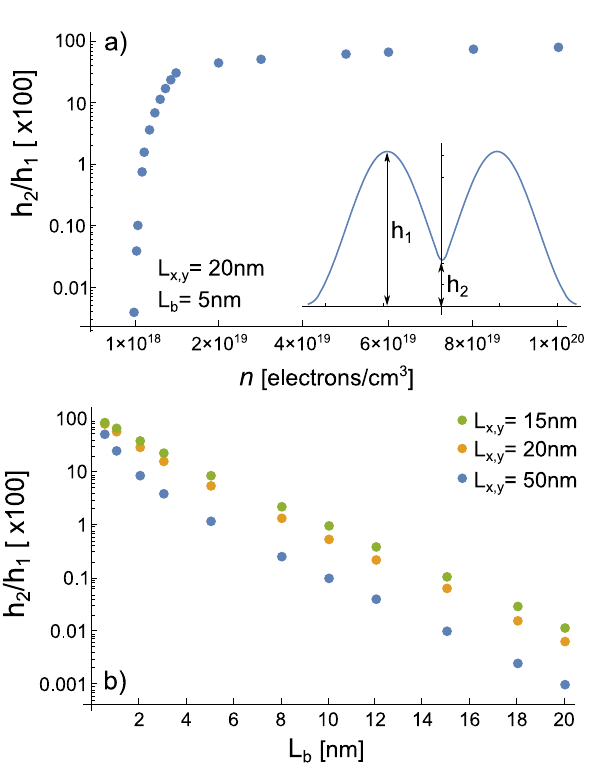
15 nm, and ( c ) first excited x , y = 10 17 electrons/cm 3 and n 10 20 = =